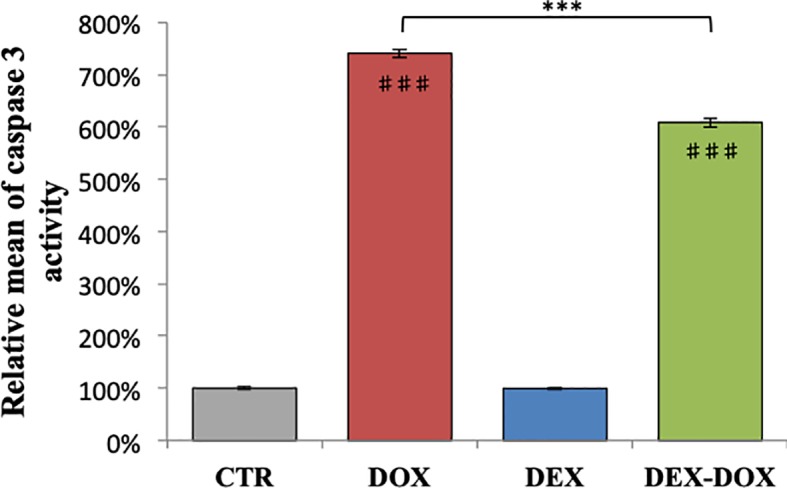
Relative mean of caspase 3 activity after 4 hours of DOX exposure. Effect of DEX alone treatment and 30 minute pre-incubation was also assessed. One-way ANOVA with multiple comparisons: ***p value < 0.001. ♯♯♯: comparison with CTR (p value < 0.001).